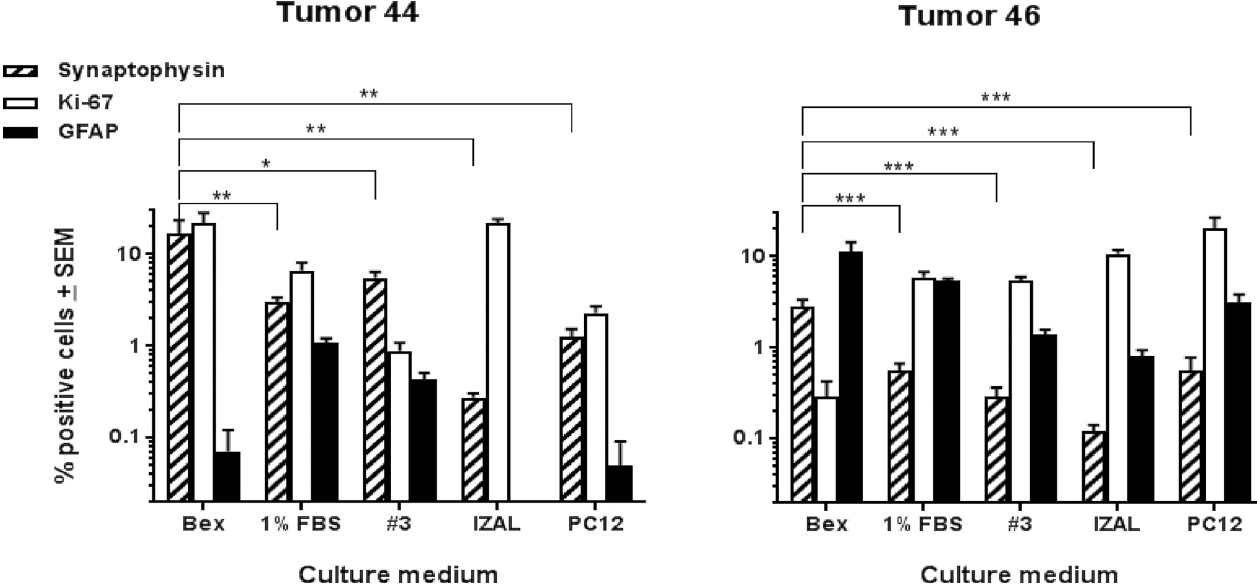
Fig 6. Comparison of five cell culture media. Tested on Tu44 (thoracic PPGL, SDHD p.(D92Y)) and Tu46 (carotid body PGL, SDHD p.(L95P)), stained with 3 marker antibodies and scored double blinded in duplo. Percentages of positive cells, with standard error of the mean (SEM), are presented in 10log scale. P values calculated with one-way ANOVA (p < 0.005) and Least Significant Differences (LSD: � p < 0.05, �� p < 0.01, ��� p < 0.005). The majority of tumours were cultured in 5 media formulations (see S1 Table for details) when sufficient tissue was available. We assessed cultures for the presence of synaptophysin as a marker for chromaffin cells and GFAP as a marker for sustentacular cells. In addition, we estimated the proportion of proliferating cells based on Ki-67 expression. In general, serum-free medium supported the highest proportion of synaptophysin-positive cells, but no long-term serum-free cultures including these cells were noted, probably because serum-free culture medium leads to the slow depletion of cells. Chromaffin cells visibly fail to prosper in this medium, often typified by poor filopodia development and poor adhesion. Media including some bovine serum, at either 1% or 5%, seemed to achieve a better balance between proliferation of fibroblasts, which may have a supportive function in these cultures, and survival of chromaffin tumour cells. Richer media such as Izal and PC12 led to a predominance of fibroblasts that appeared detrimental to the survival of chromaffin cells, possibly due to the rapid consumption of available metabolites in the